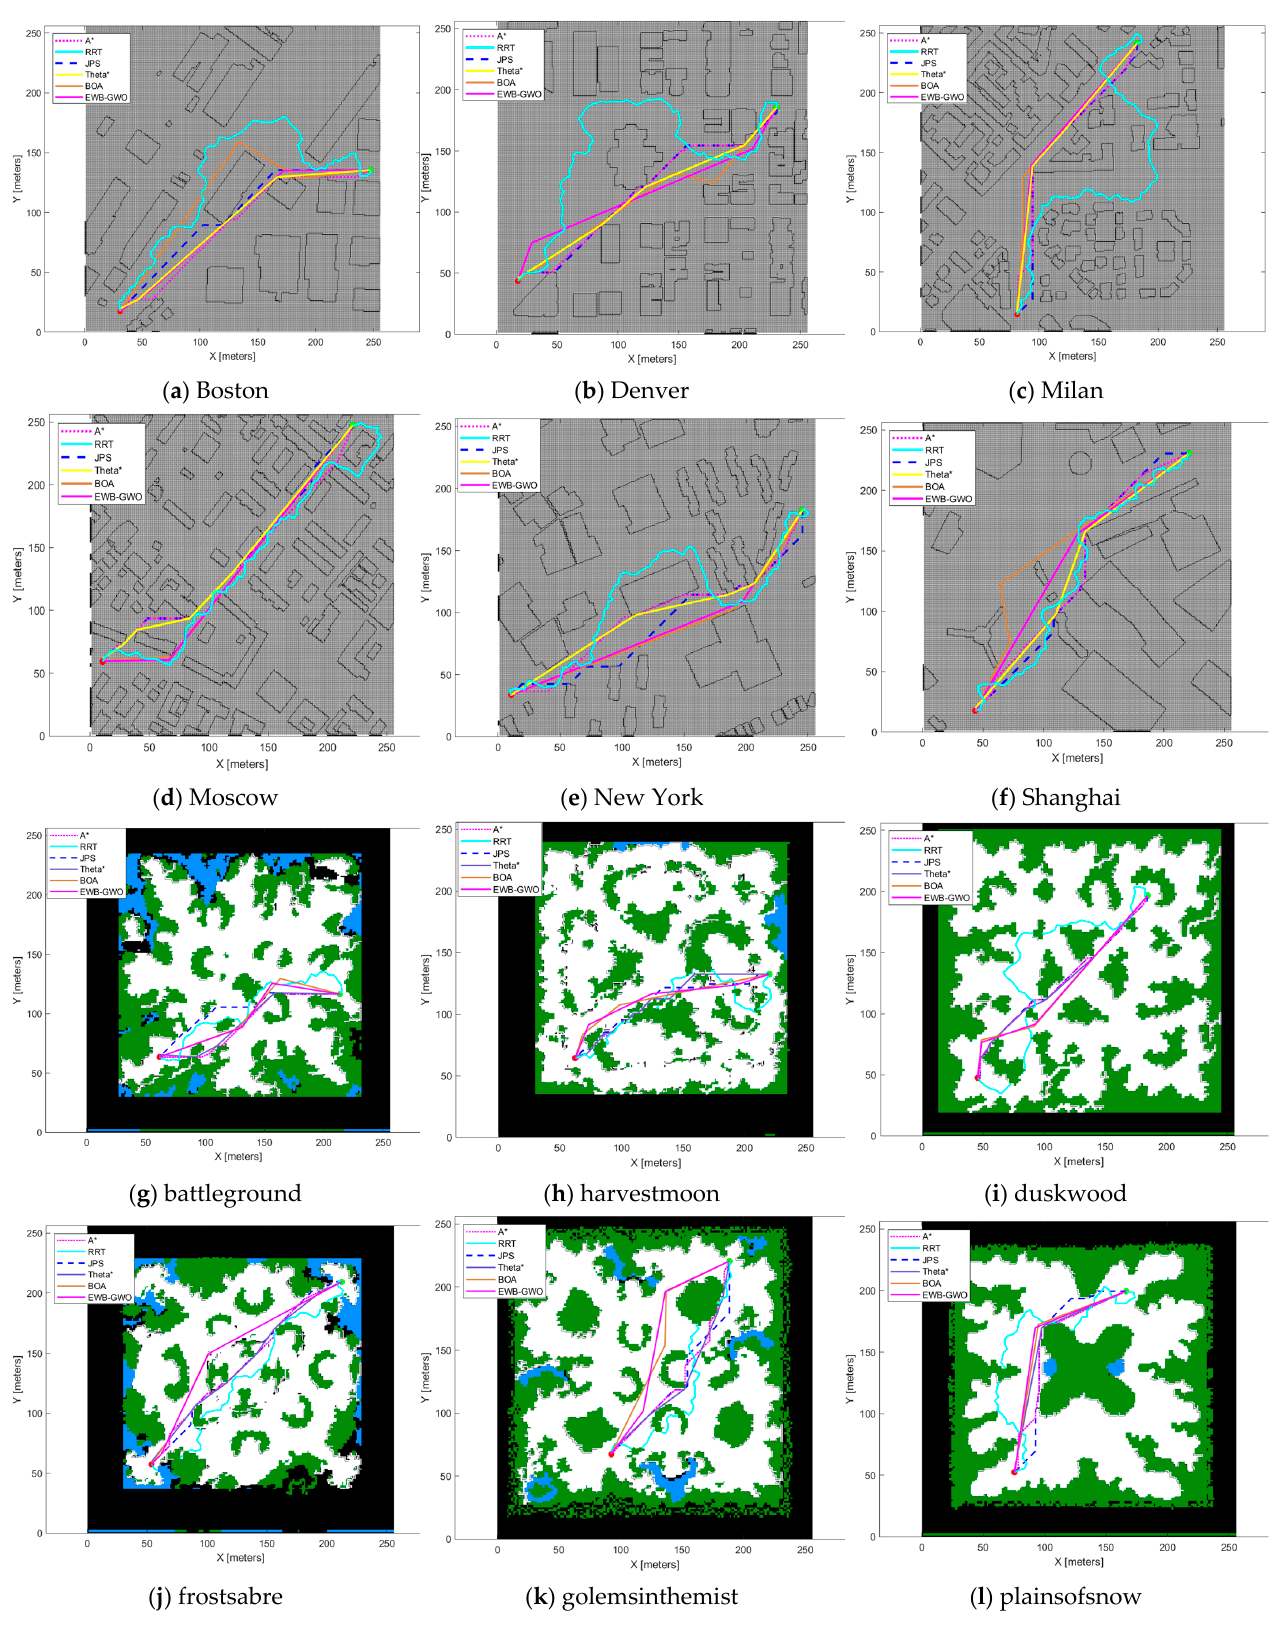
Figure 15. Simulation diagram of drone path planning experiment.